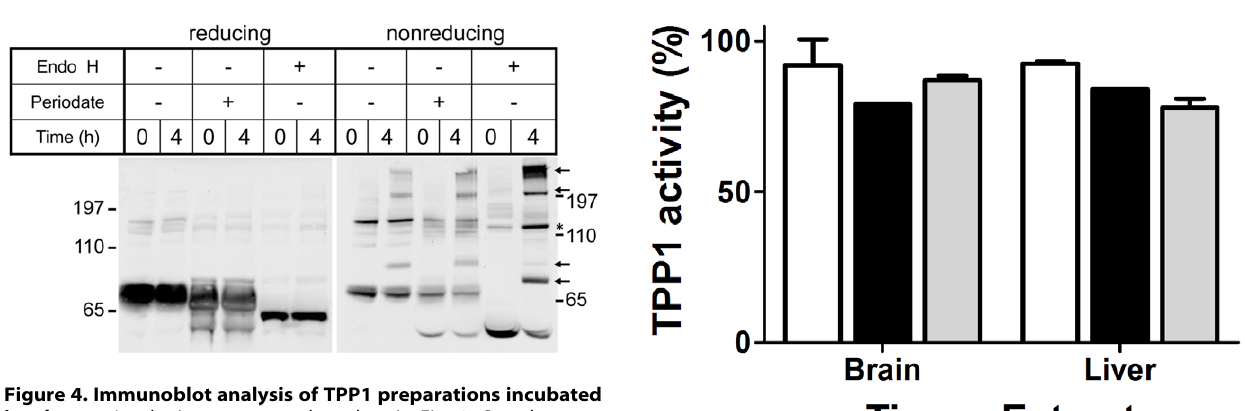
Figure 4. Immunoblot analysis of TPP1 preparations incubated in plasma. Incubations were conducted as in Fig. 3. Samples were heated in denaturing SDS-PAGE sample buffer that either contained or lacked 5 mM dithiothreitol as indicated (reducing or nonreducing). doi:10.1371/journal.pone.0040509.g004 Figure 5. In vitro stability of TPP1 preparations in tissue